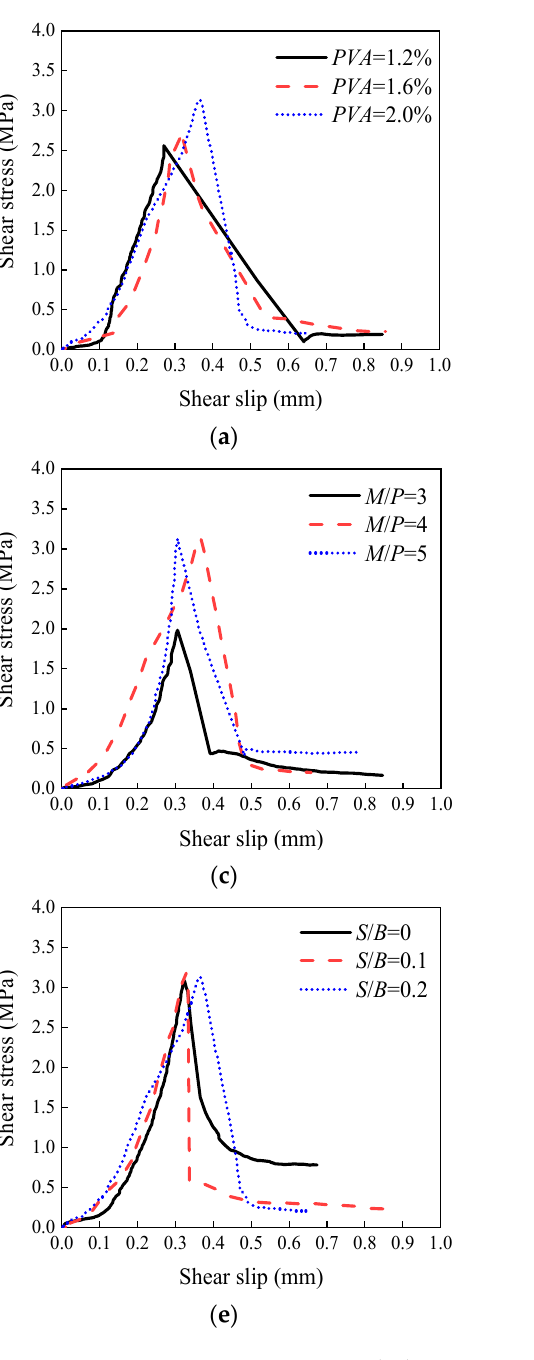
G f 3 are influence coefficients of M / P on τ u , S u , and G f , respectively; τ u 4 , S u 4 , and G f 4 are influence coefficients of W / S on τ u , S u , and G f , respectively; τ u 5 , S u 5 , and G f 5 are influence coefficients of S / B on τ u , S u , and G f , respectively; τ u 6 , S u 6 , and G f 6 are influence coefficients of fly ash content on τ u , S u , and G f , respectively. The following (Figures 13–15) are the results of polynomial fitting for each influence coefficient.